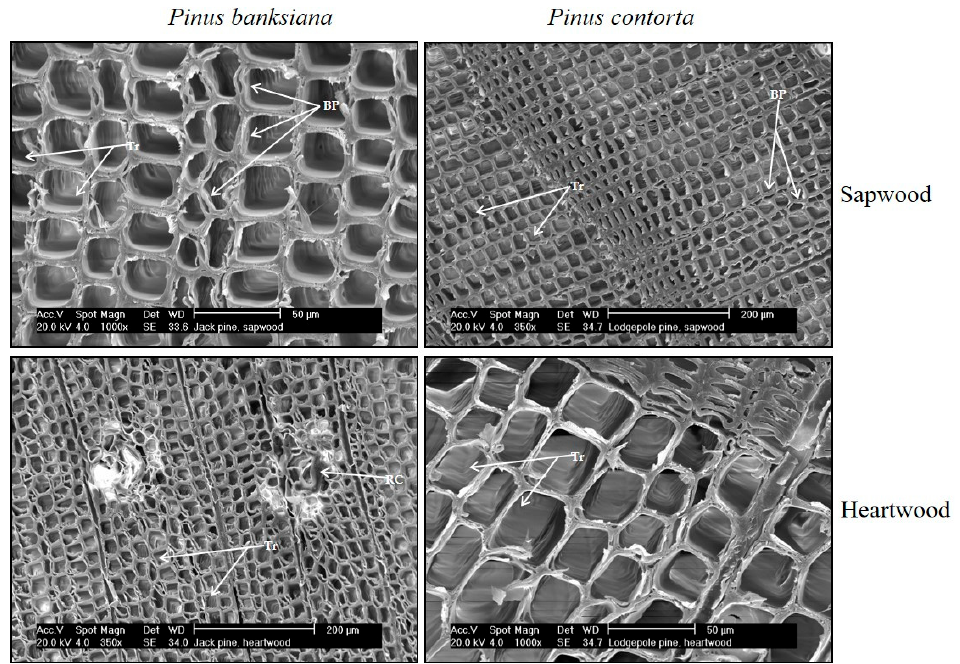
Figure 1. Scanning electron micrographs of Pinus banksiana and Pinus contorta stems tissues. Notice the clogged resin canals (RC) in the Pinus banksiana heartwood. The sapwood micrographs show the bordered pits (BP) between tracheids (Tr).